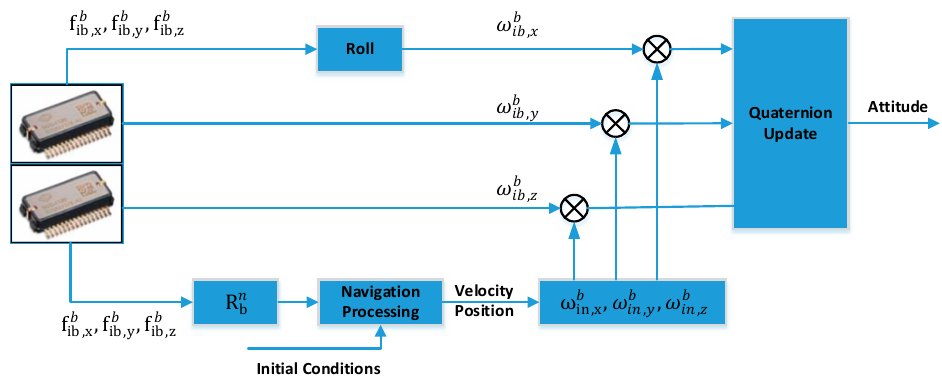
Figure 3. Miniature Gyroscope-Based While Drilling (MGWD) system attitude solution diagram.